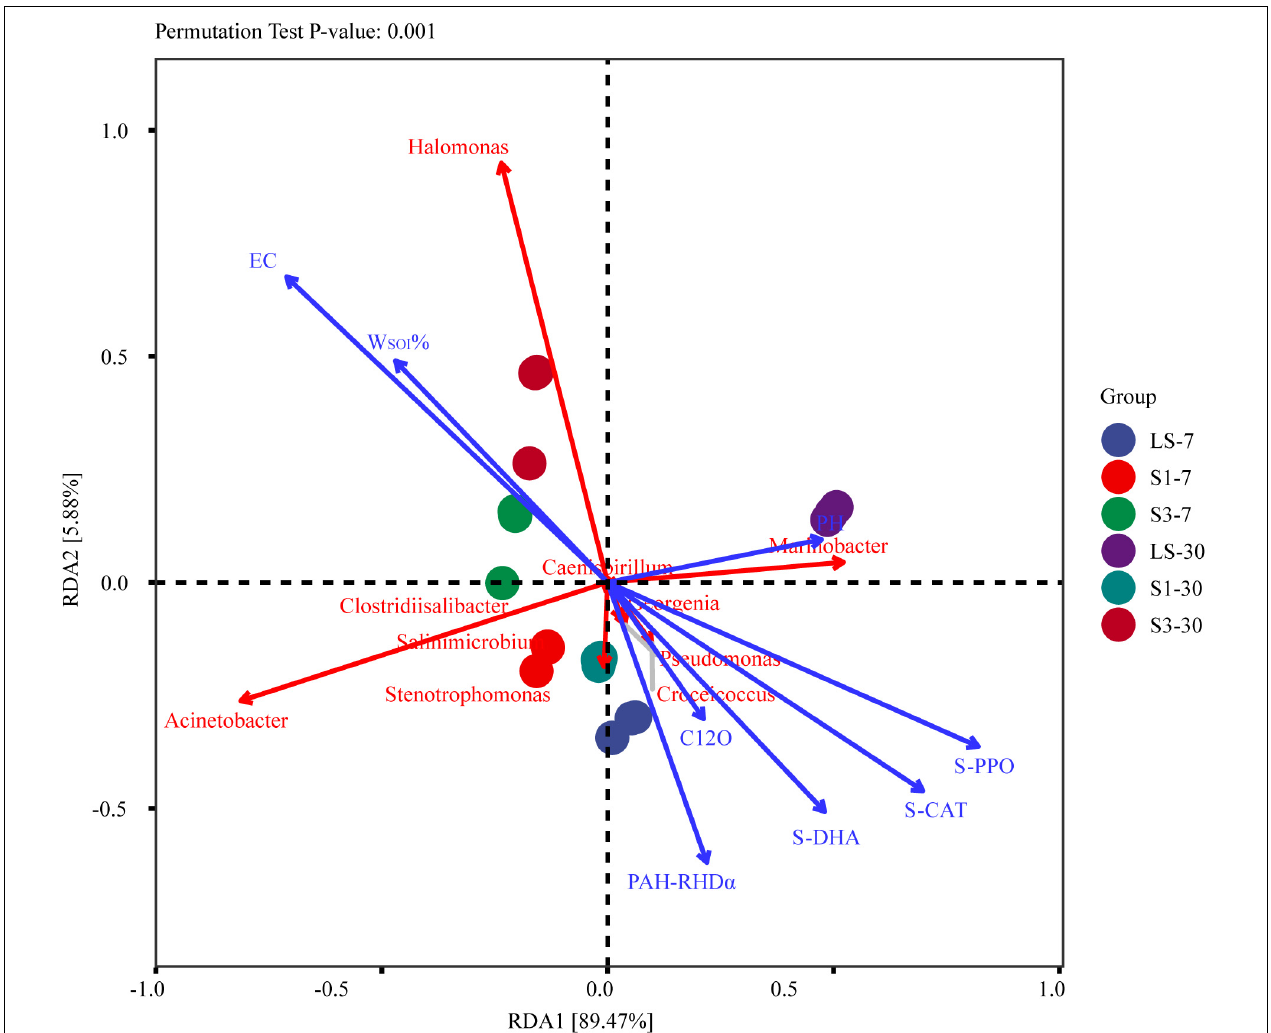
FIGURE 9 | Redundancy analysis (RDA) ordination plot to show the relationships among the soil physicochemical parameters, degradation genes, enzyme activities and the relative abundance of top 10 bacterial genera. The red arrow represents the species, and the length of the arrow represents the variability of species in the sorting space. The blue arrow line represents the influencing factor, and the length represents the influence of the factor on the composition and function of the